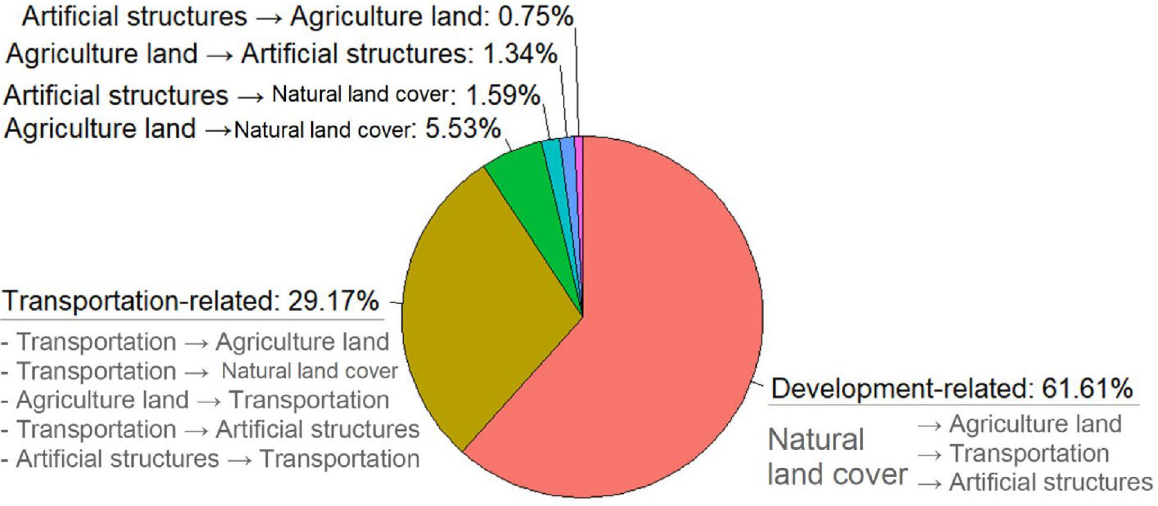
Figure 6. Percentage of RIFA sampling tubes in the category of land-use change from 2014 to 2017 (N = 1193). The land-use type before the arrow is the type in 2014. The land-use type after the arrow is the type in 2017.